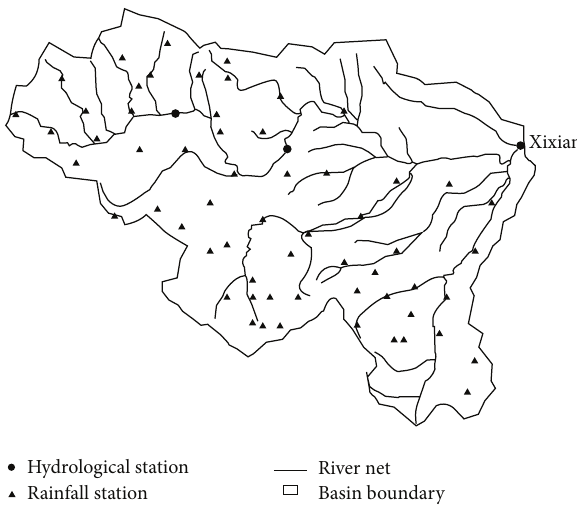
Figure 1: Sketch map of the upper Huaihe River